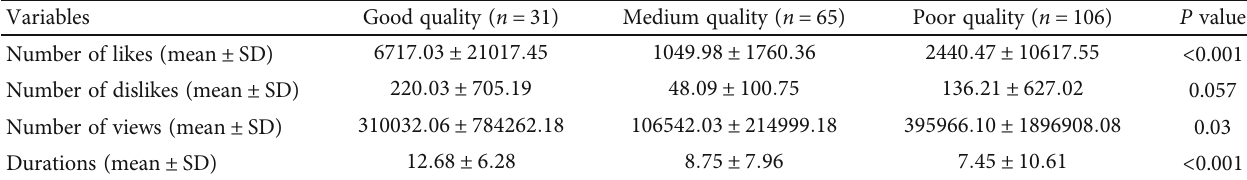
Table 6: Analysis of variables in relation to YouTube contents quality on hydroponic technology.